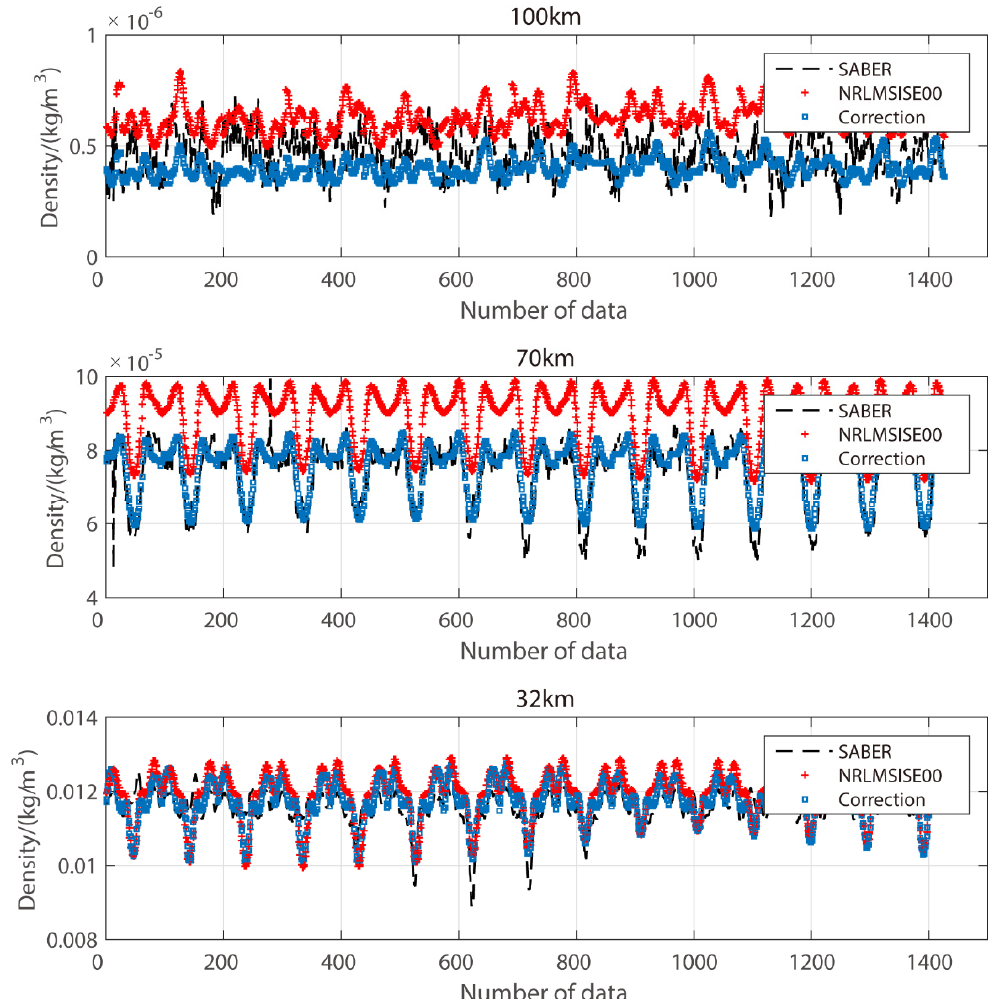
Figure 7. Density variations at different heights during a geomagnetic storm (day 251 of 2017) at ( a ) 100, ( b ) 70, ( c ) 32 km. The black line refers to TIMED/SABER density. The red asterisk refers to NRLMSISE-00 density before correction. The blue square refers to NRLMSISE-00 density after correction. Table 2. Atmospheric density error on satellite orbits at different nodes on day 251 of 2017 (%).